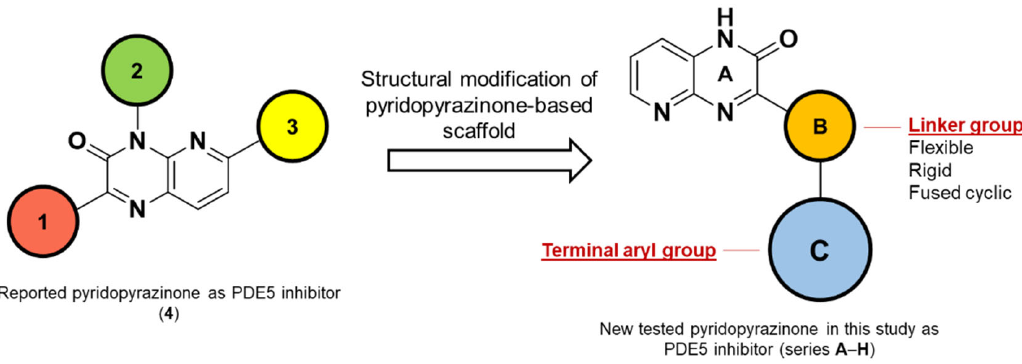
Figure 3. Rational structural modification of the reported pyridopyrazinone ‐ based derivatives as PDE5 inhibitors. The orientation of the terminal groups is modified structurally. In the reported inhibitors, pyridopyrazinone scaffold is designed to be the central motif. In the tested compounds, the pyridopyrazinone ring is functioning as one of binding motifs.